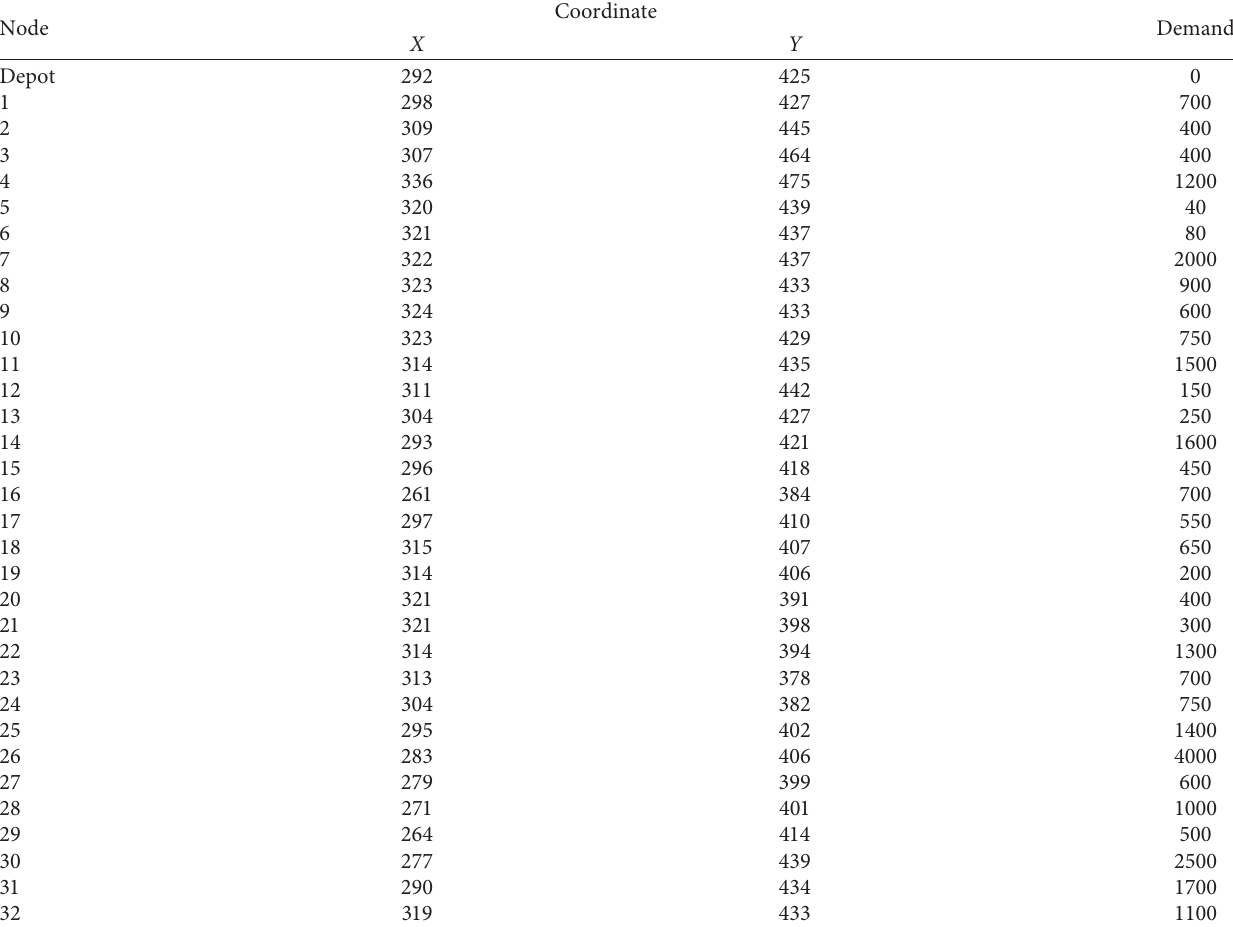
Table 2: Problem of 32